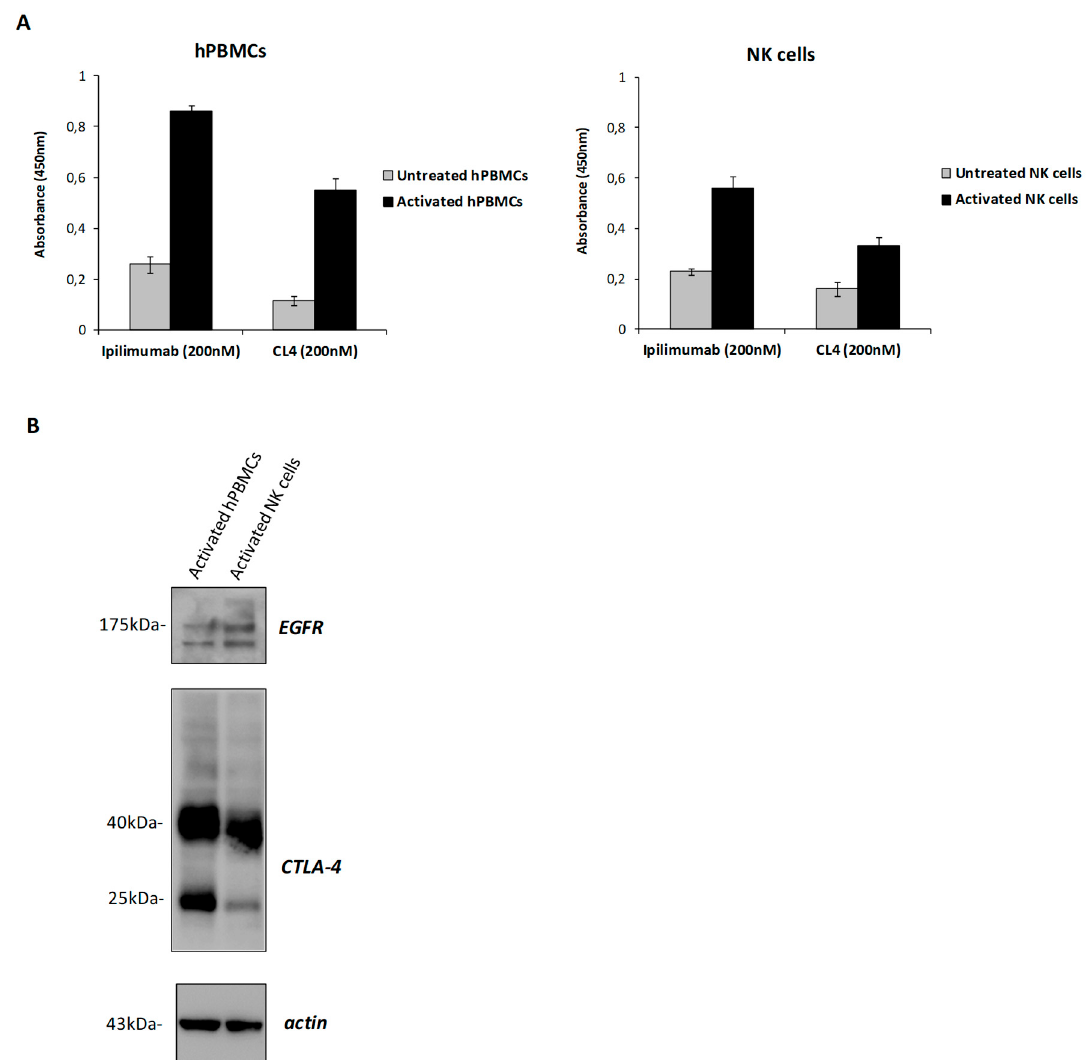
Figure 5. Expression level of EGFR and CTLA-4 on untreated or activated hPBMCs and NK cells. ( A ) Cell ELISA assays with ipilimumab and CL4 (200 nM) on hPBMCs and NK cells, untreated (grey bars) or activated (black bars) with α -CD3 / CD28 beads or SEB, respectively. Error bars depict means ± SD. ( B ) Western blotting with commercial anti-CTLA-4 and anti-EGFR antibodies of cell extracts from activated hPBMCs or NK cells. The intensity of the bands was normalized to actin.